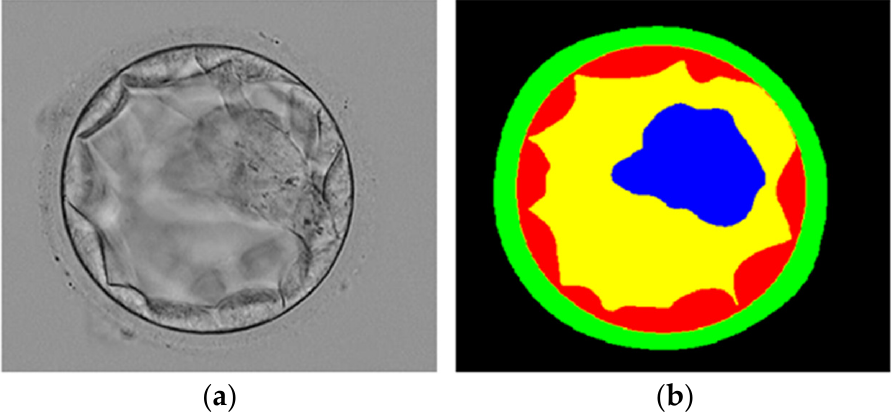
Figure 2. Example blastocyst microscopic image: ( a ) original image, ( b ) manual expert embryologist label image.